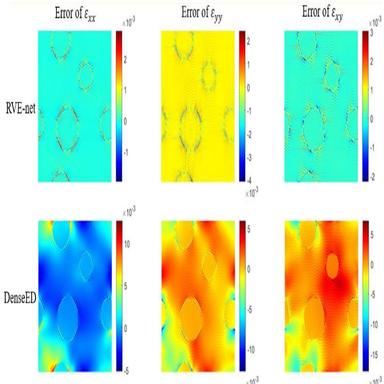
Errors of strain fields obtained by the RVE-net and DenseED with 20 channels.